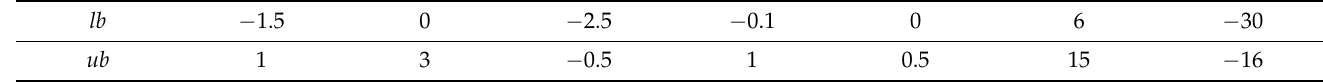
Table 2. The optimization